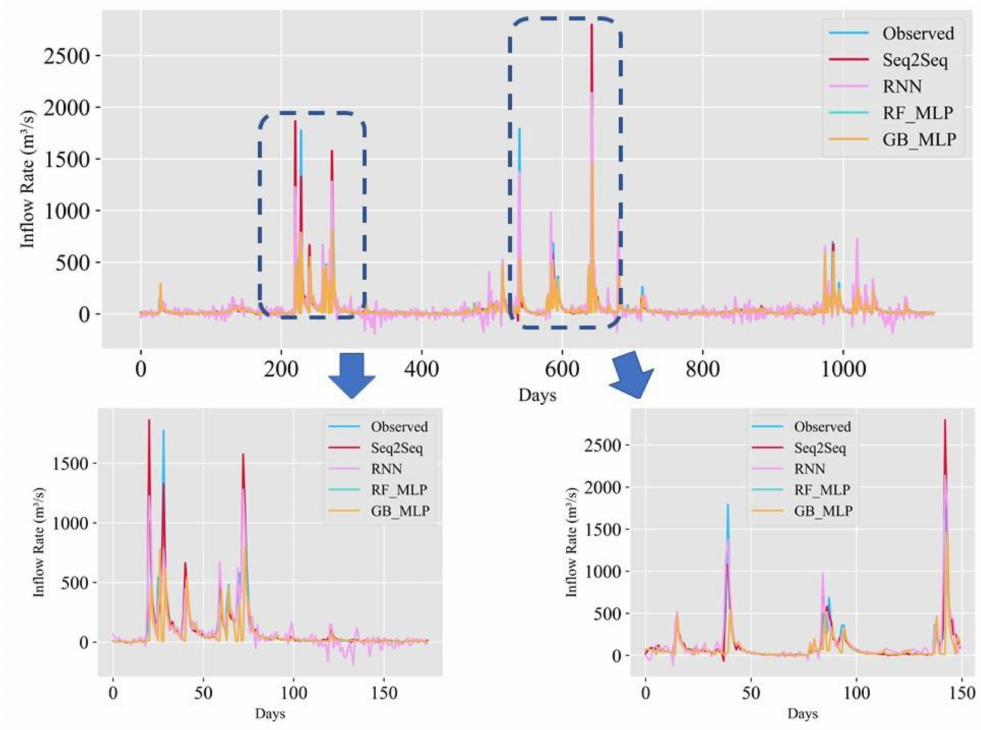
Figure 10. Time variation graph for the proposed model RNN, RF_MLP and GB_MLP.